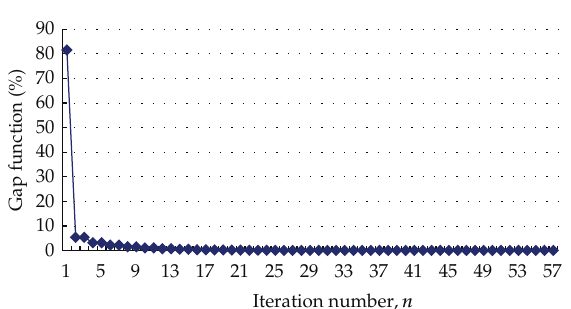
Figure 3: Convergence characteristics of assigned flow for θ (cid:9) 1 . 0.